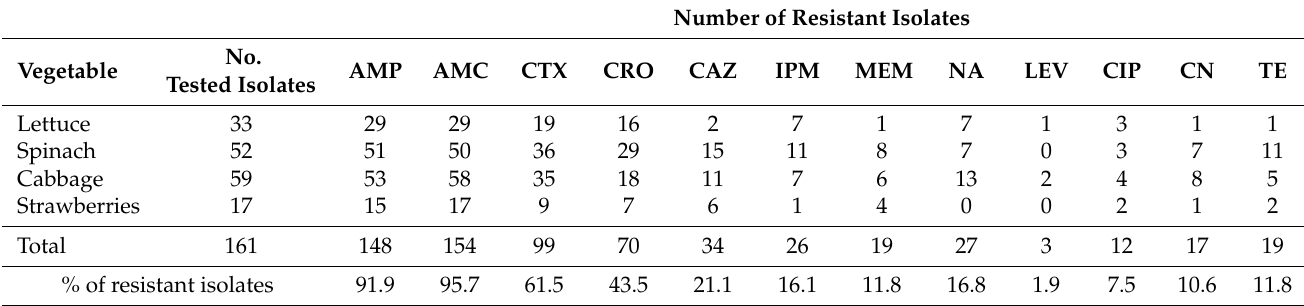
Table 2. Incidence of resistance to each antimicrobial compound in the isolates. Number of Resistant Isolates